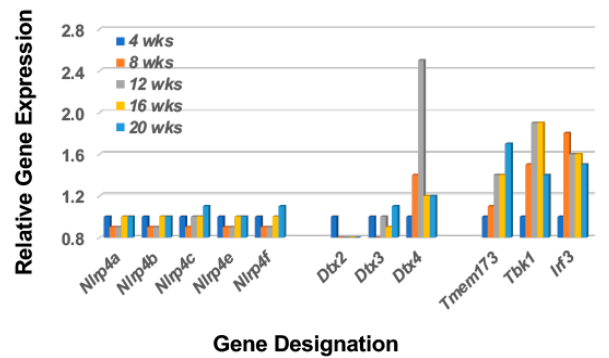
Figure 2. A transcriptome profile that predicts activation of the type 1 IFN response despite upregu- lation of Dtx expression. The transcriptome profile of the lacrimal glands of C57BL/6.NOD- Aec1Aec2 mice indicate a lack of an upregulated Nlrp4 gene expression and thereby a concomitant targeting of Tbk1 by Dtx4. This profile would explain the strong upregulation of the signal transduction pathway for Type 1 interferon and activation of the interferon-signature characteristic of SS.